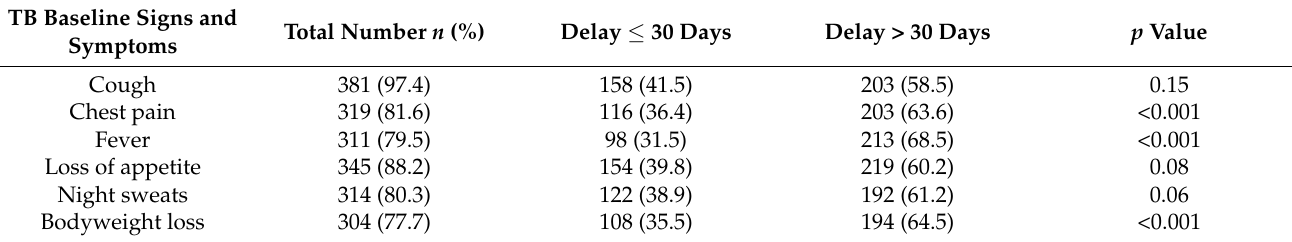
Table 2. TB Baseline signs and symptoms n = 391 ( ≤ 30 days vs.